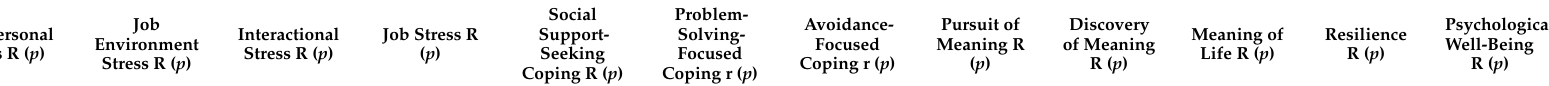
Table 3. Correlations of the variables (N =